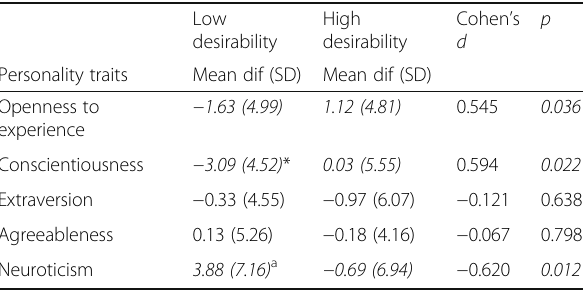
Table 3 Differences between times of assessment on personality traits stratified by desirability score (follow-up assessment-baseline